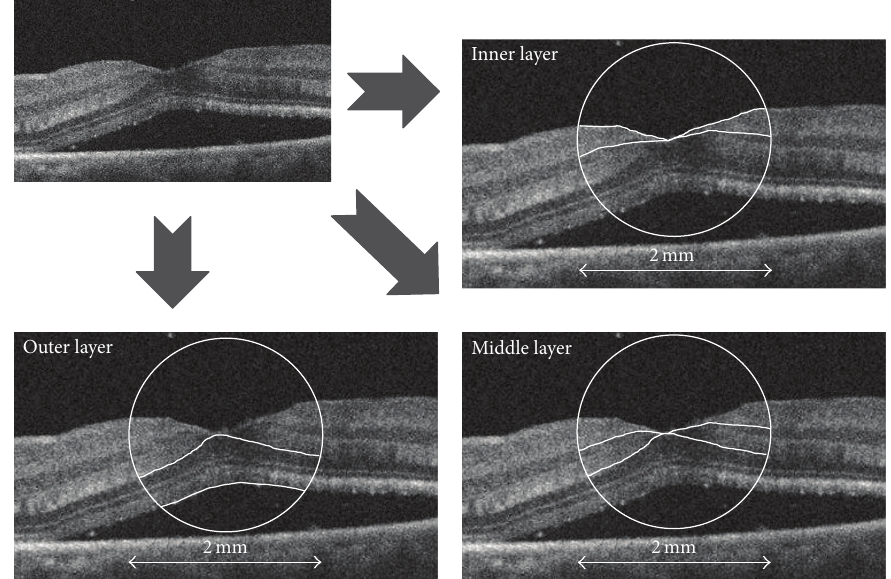
Figure 1: Preoperative optical coherence tomography (OCT) images. A circle with a diameter of 2mm was manually centered at the foveal surface center of the detached macula in the OCT image. The macular area within the circle was divided into three sections: the inner layer (upper right: nerve fiber layer and ganglion cell layer), middle layer (lower right: inner plexiform layer and inner nuclear layer), and outer layer (lower left: outer plexiform layer and outer nuclear